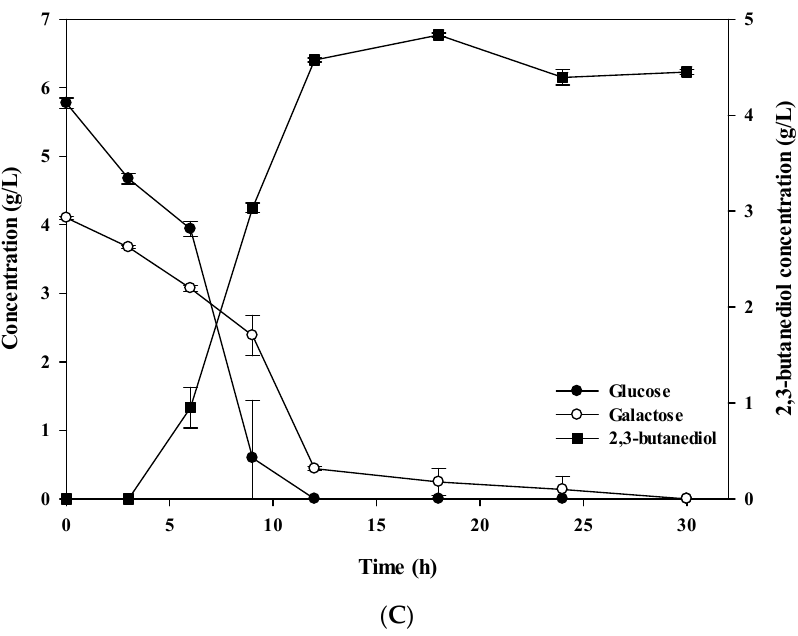
Figure 1. The fermentation of K. aerogenes ATCC 29007 using chemical sugars and extracted algal sugars for 2,3-BDO production. ( A ) Comparative experiment by pH concentration, ( B ) 2,3-BDO production using chemical sugars, and ( C ) 2,3-BDO production using extracted algal sugars.